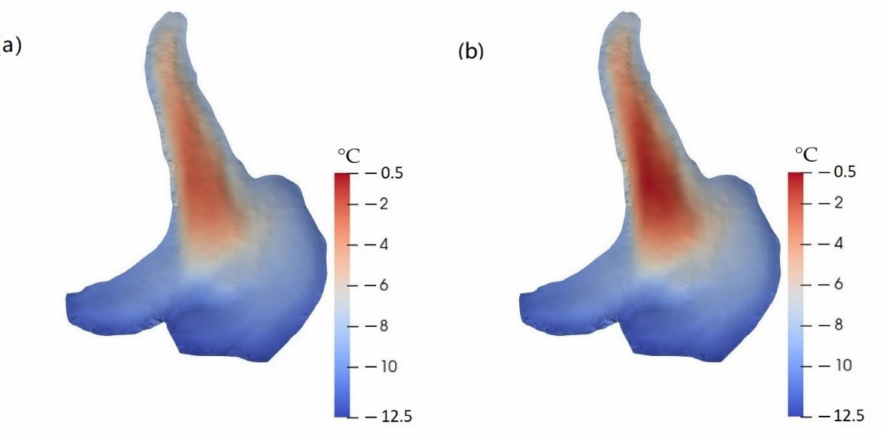
Figure 12. Distribution of temperature relative to pressure melting point at the bedrock with geother- mal heat flux of 50 ( a ) and 60 ( b ) mW m − 2 .